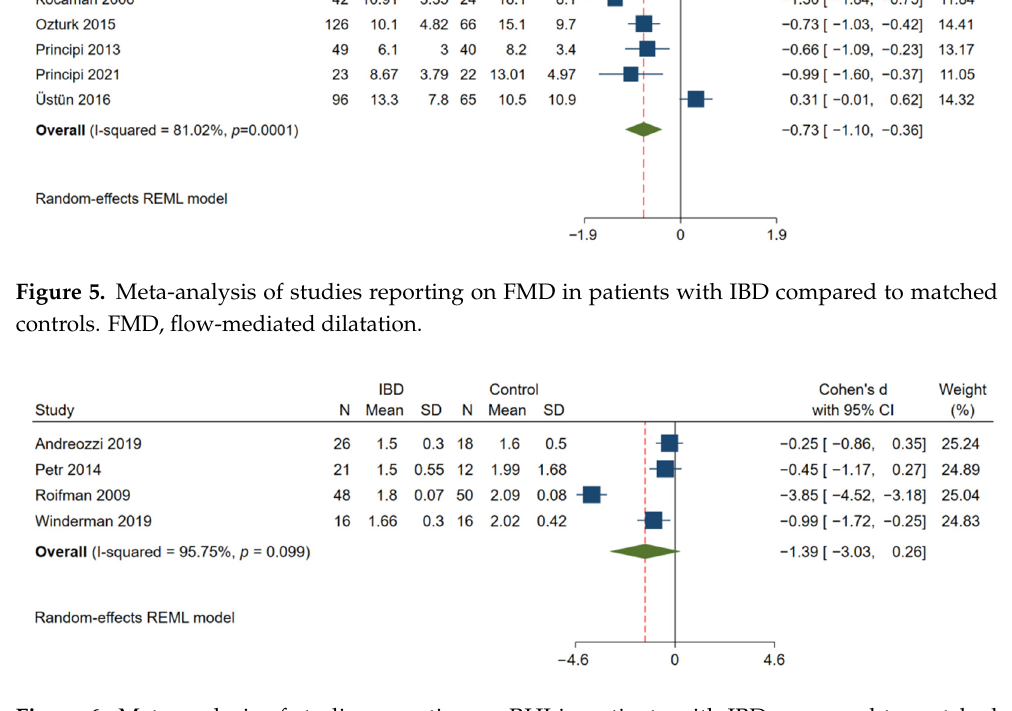
Figure 6. Meta-analysis of studies reporting on RHI in patients with IBD compared to matched controls. RHI, reactive hyperemia index.